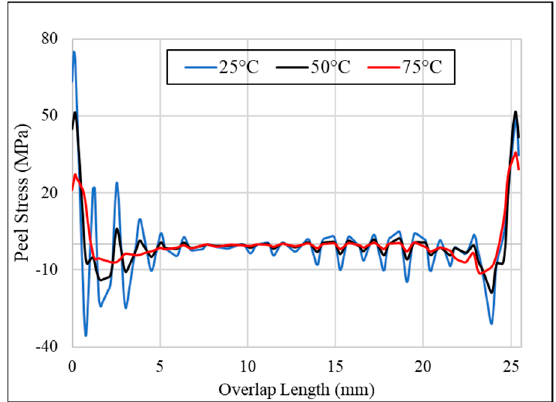
Figure 15. Peel stress distribution at location B of SLJ with Al 2 O 3 nanoparticles in the adhesive at different temperatures.